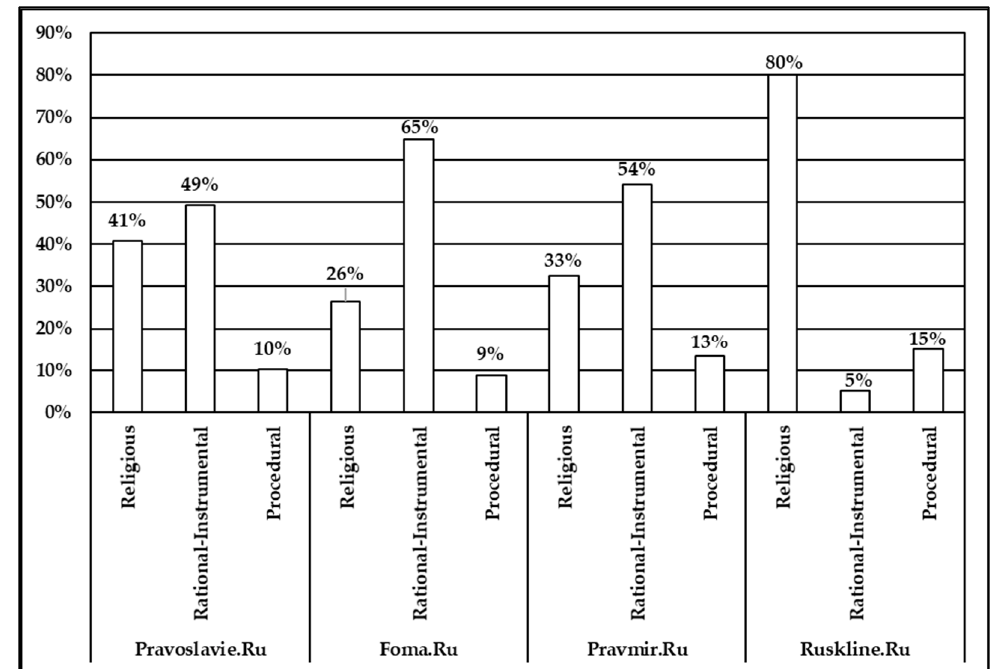
Figure 3. Dominant morality policy frames, % of articles where found by portal.